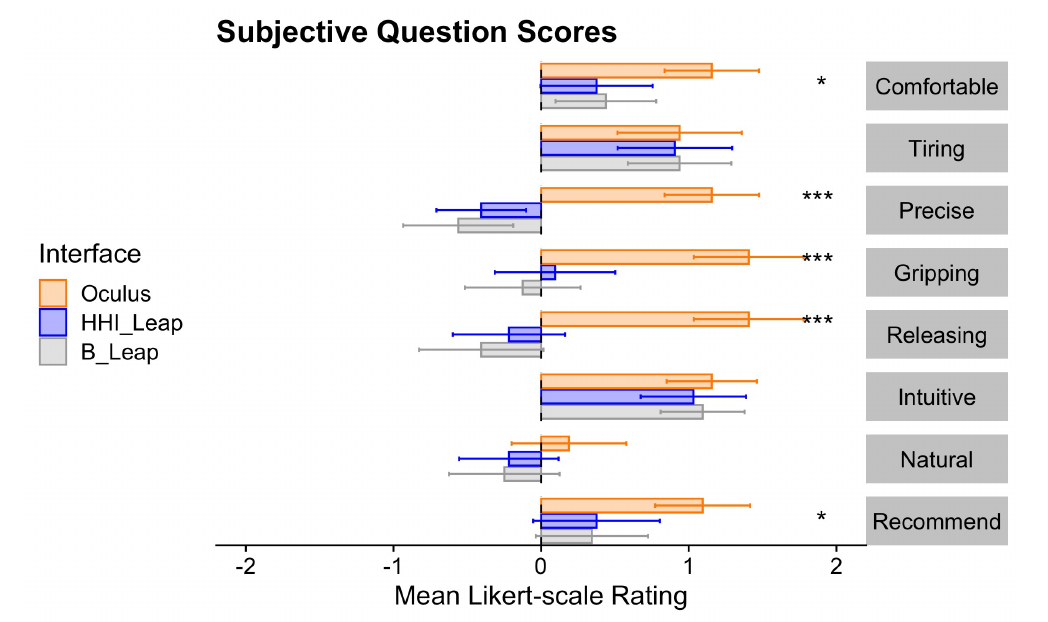
Figure 10. Mean scores for subjective questions, converted to a scale of − 2 to 2, with 95% CI. * = p < 0.05, *** = p < 0.001. All significant differences are between Oculus and HHI_Leap.